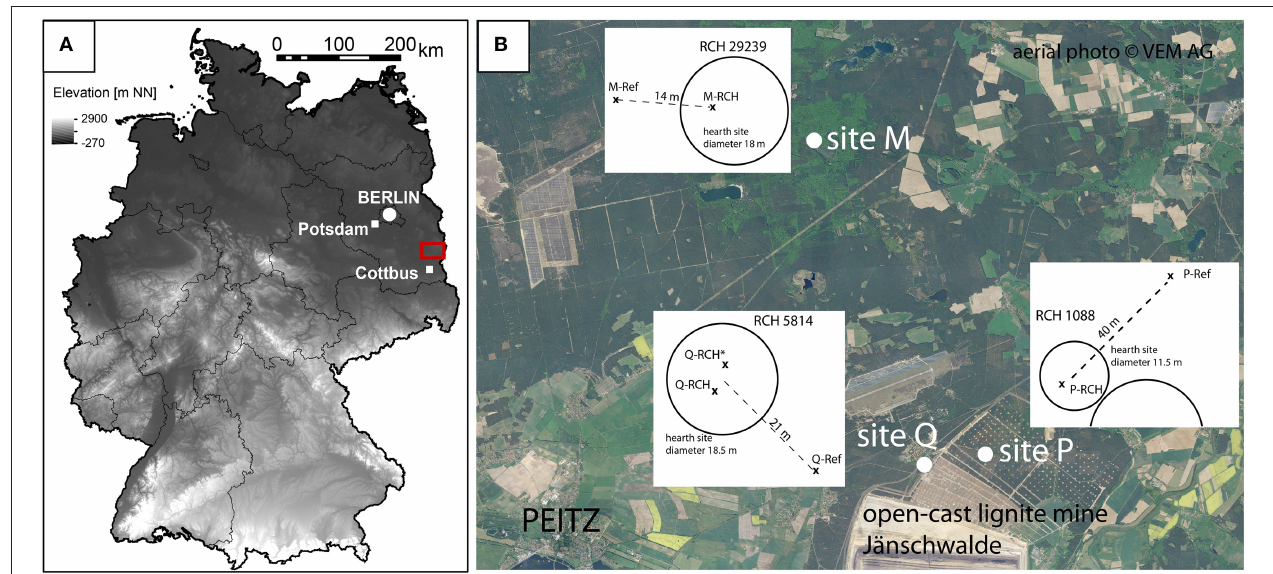
FIGURE 1 | Location of the study area north of Cottbus, Germany (A) in the position of the study sites on an aerial photograph of the area around the forefield of the open-cast lignite mine Jänschwalde and the forest area around Tauer (B) . Sketches of the sites (not to scale) show the position of the individual plots.